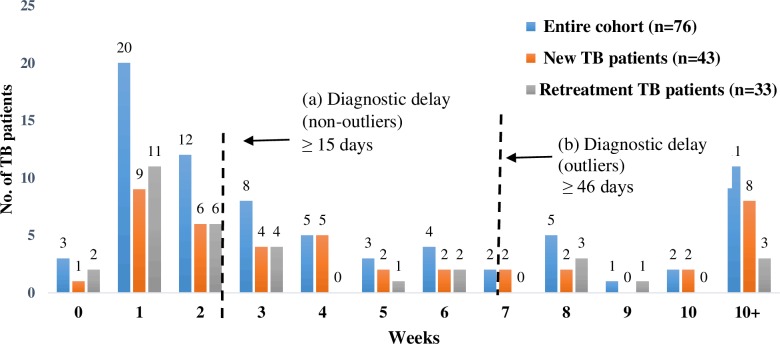
Diagnosis: Duration and Delays.The figure represents the time taken from first contact with any health care provider to receiving PTB diagnosis. The serrated lines depict the durations that reflect (a) delay and (b) outliers.